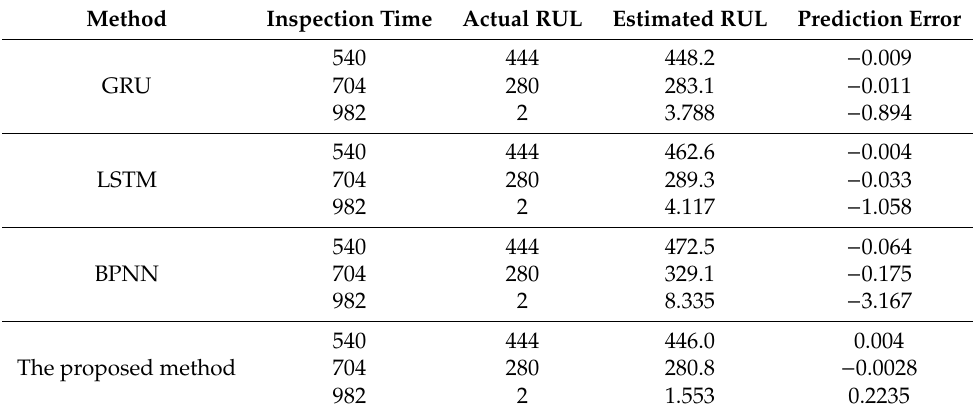
Table 2. Estimated RUL results of the four